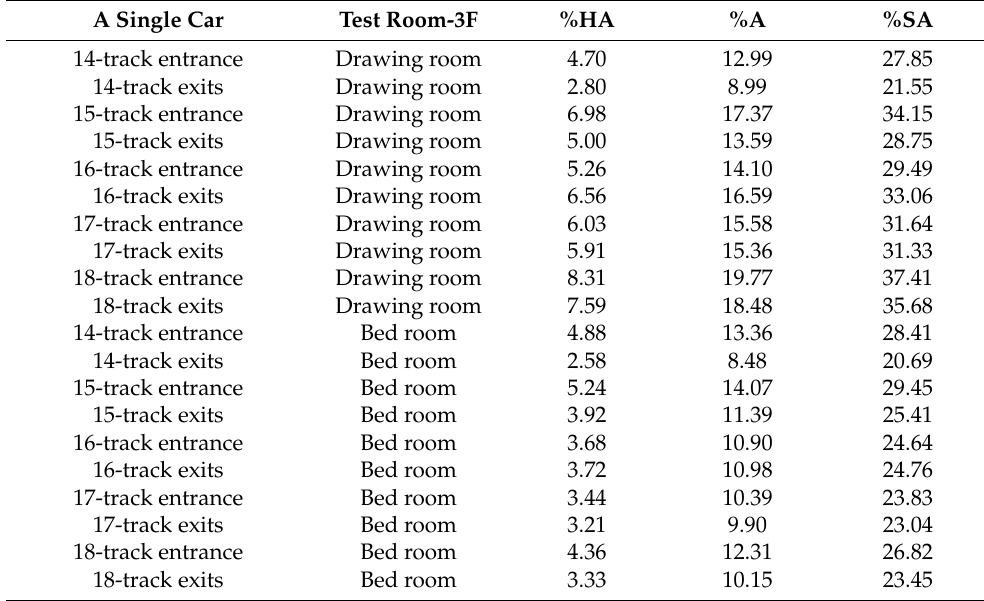
Table 10. Vibration annoyance rate of the third-floor test room during a single-train operation.